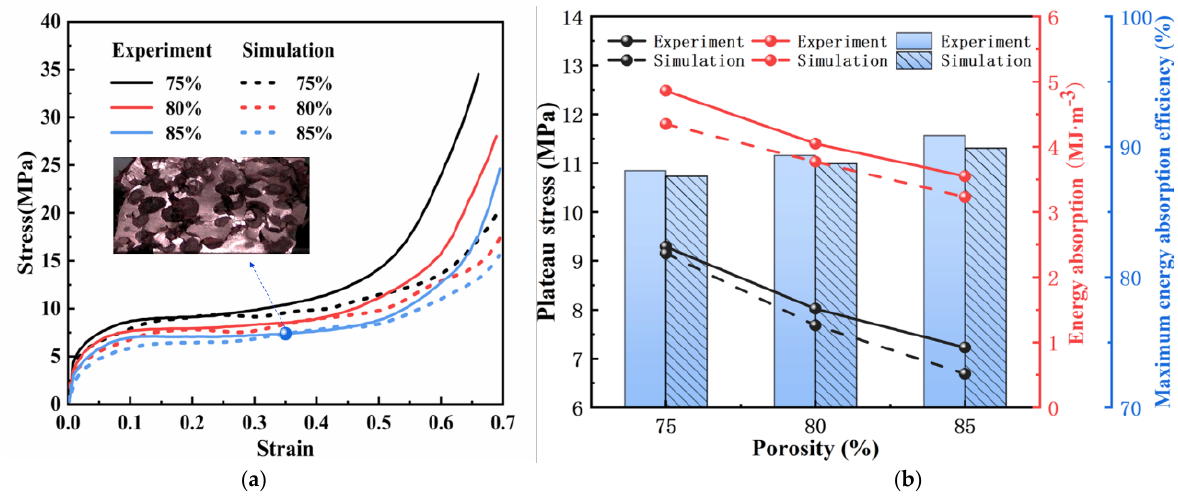
Figure 8. ( a ) Compressive stress–strain curves and ( b ) related properties of OCCF with different foam porosity, from both experiments and FE simulations.